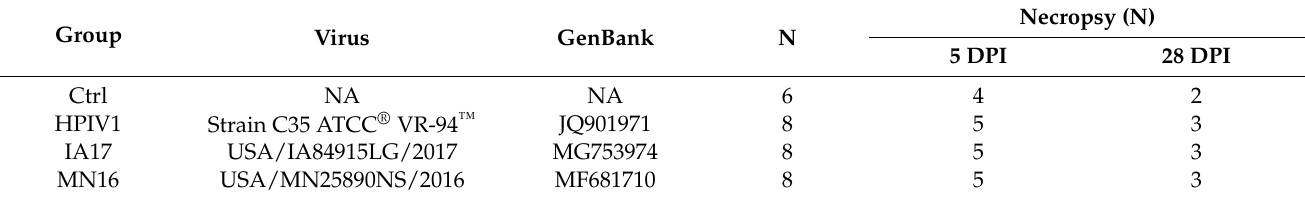
Table 1. Experimental design comparing challenge with Human parainfluenza virus 1 (ATCC ®